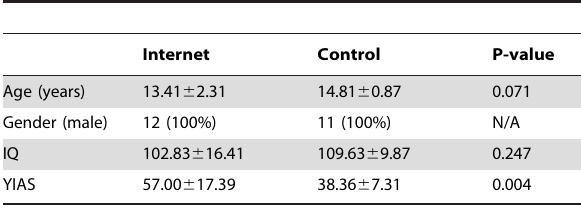
Table 1. Demographic and clinical characteristics of the